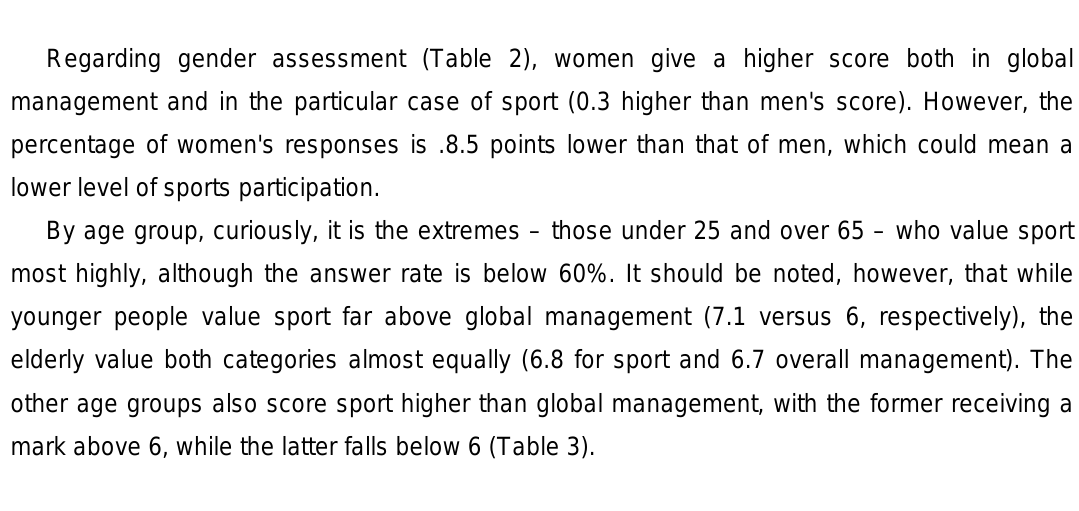
Table 3. Average assessment of municipal management by age group (2017). Global Sport